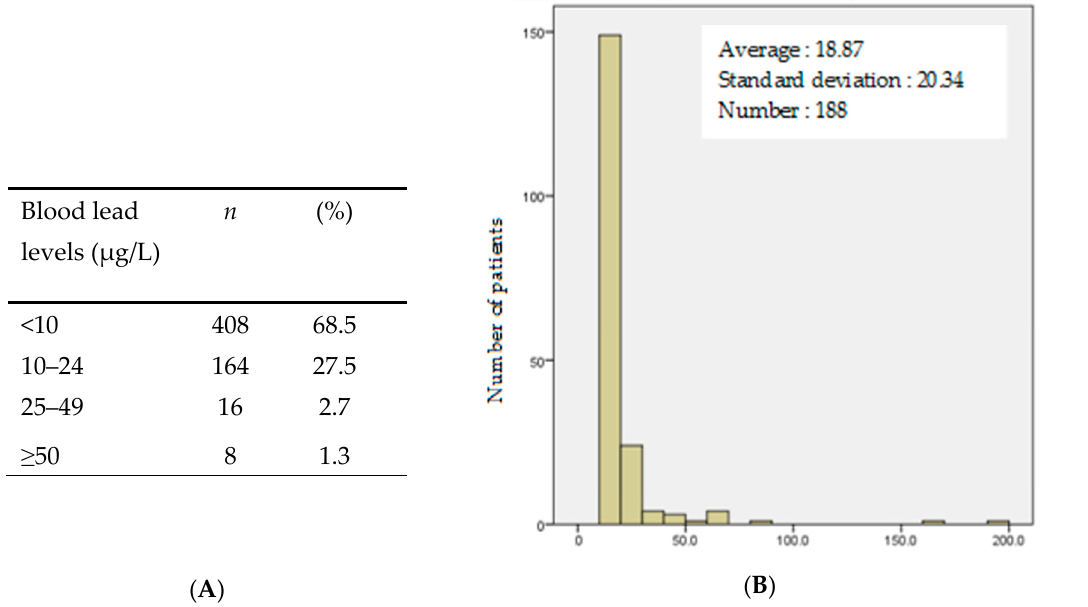
Figure 1. Distribution of blood lead levels in the sample ( A ) Presents categorical distribution of blood lead level values ( n = 596). Note that laboratories sometimes reported “below 10 µ g / L” rather than accurate value. ( B ) Distribution of blood lead levels above 10 µ g / L. Table 3. Multivariate analysis of factors significantly associated with lead poisoning.